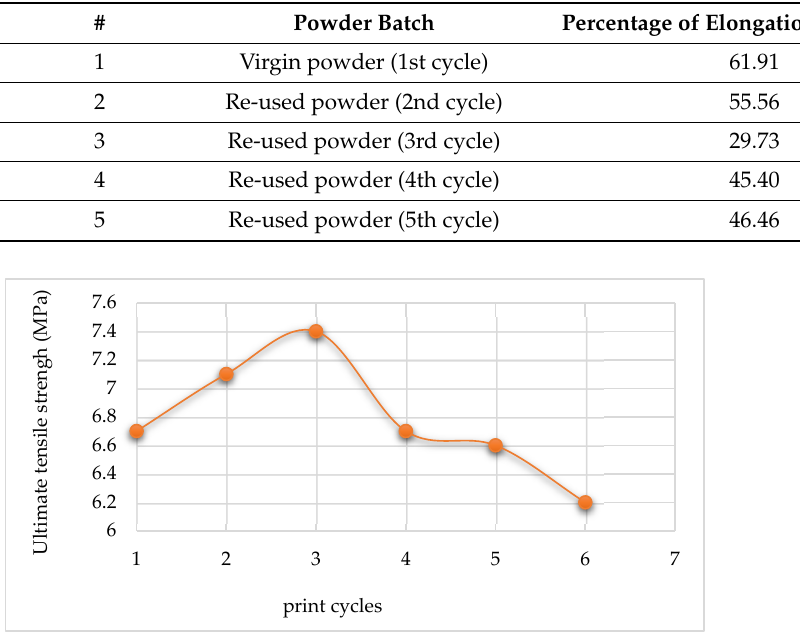
Figure 17. Ultimate tensile strengths of parts printed using Laser PP CP 75. In Figure 17, the tensile strength of the printed parts increased slightly, from 6.7 MPa to 7.4 MPa, with the re ‐ use of powder up to the 2nd re ‐ use cycle. After the 2nd re ‐ use cycle, the tensile strength value of the printed parts decreases to below that of the parts printed from fresh powder. Table 11. Young’s modulus of printed parts after 100% re ‐ use. Table 12. Percentage of elongation at break of printed parts after 100% re ‐ use.